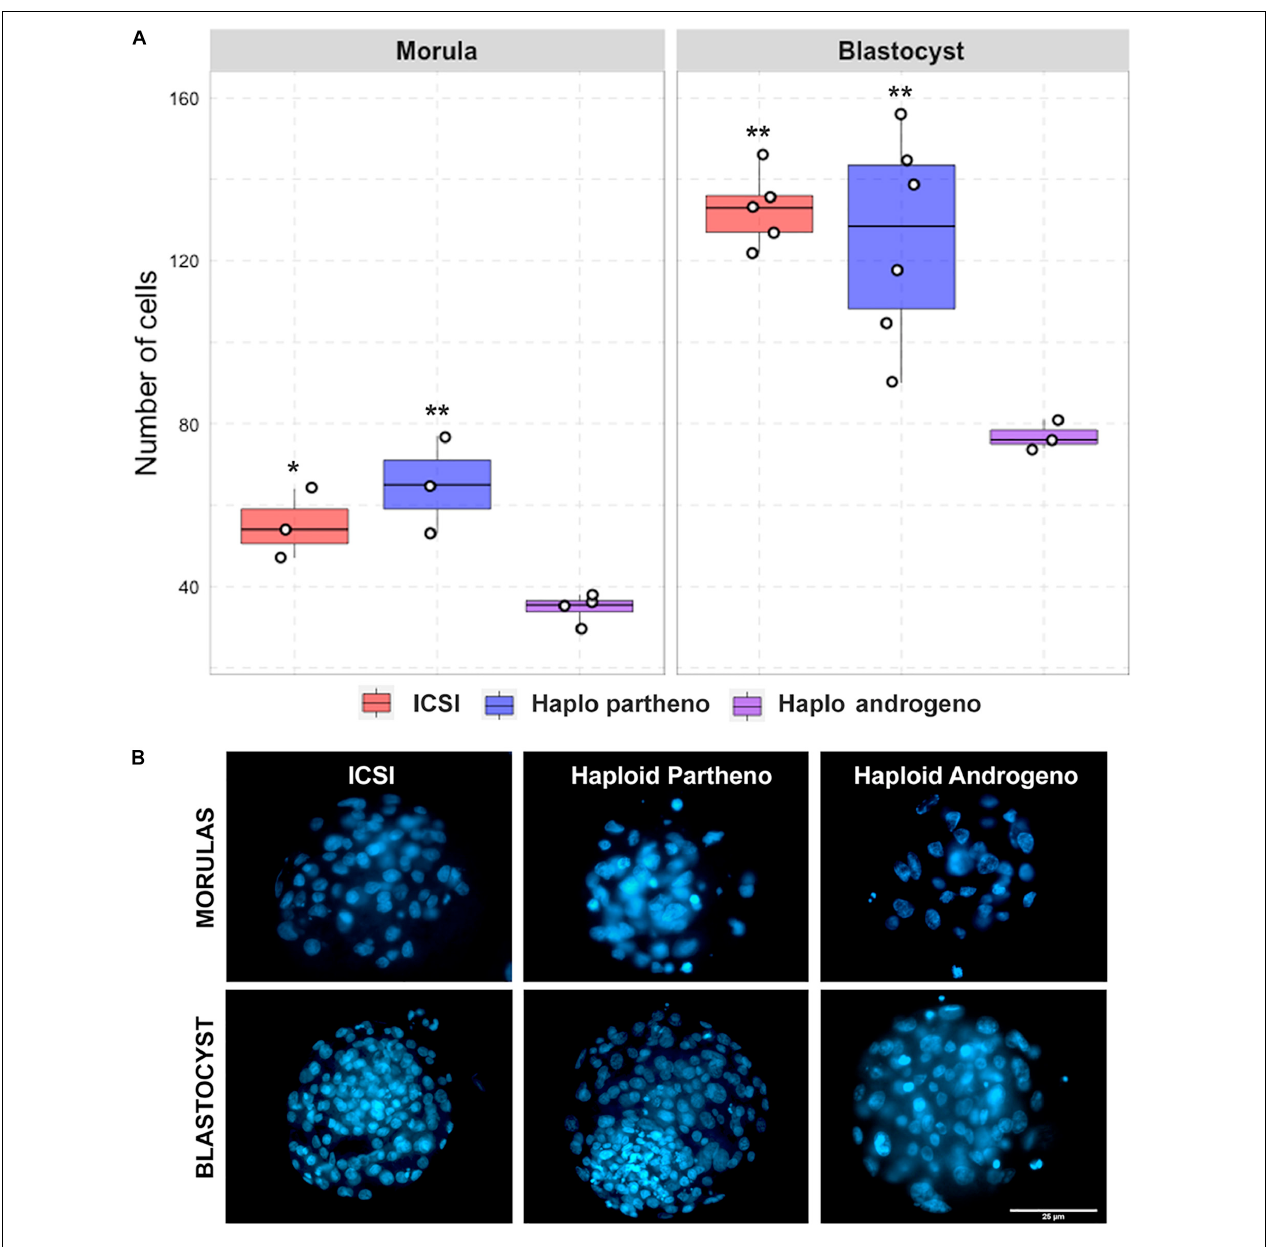
FIGURE 4 | Cell number of diploid and haploid morula and blastocyst stage embryos. (A) Nuclear counts and (B) representative images of morula and blastocyst stage embryos harvested at Day-6 (144 h) and 168 h (Day-7) of culture, respectively. IVF, in vitro fertilized; ICSI, intracytoplasmic sperm injection using female-sorted semen; Haploid partheno, haploid parthenogenetic embryos obtained by oocyte activation using ionomycin followed by cyclohexymide; haploid androgeno, haploid androgenetic embryo obtained by ICSI + oocyte enucleation. ∗ p < 0.05, ∗∗ p < 0.01. Scale bar = 25 µ m.